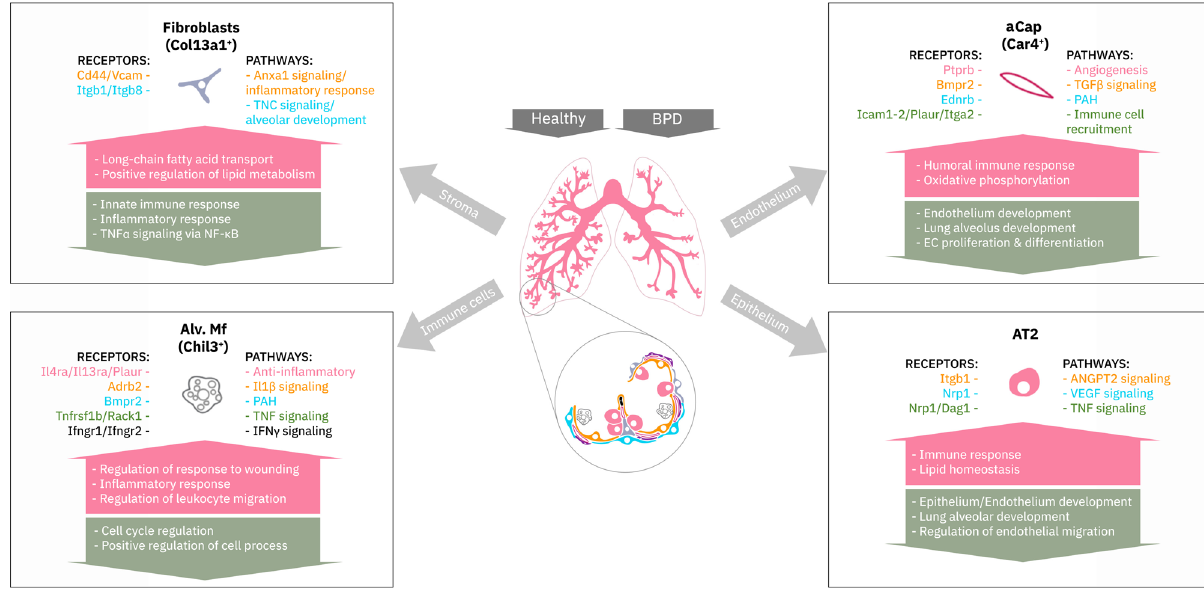
Fig. 9 Summary of the cellular crosstalk and pathway analysis in hyperoxia-impaired late murine lung development. Mouse lung cell subtypes with the most signi fi cant gene expression changes in hyperoxia mimicking bronchopulmonary dysplasia (BPD). Activated receptors and their involved biological pathways are indicated by the cell communication inference analysis. Biological processes in the arrows are indicated by the gene set enrichment